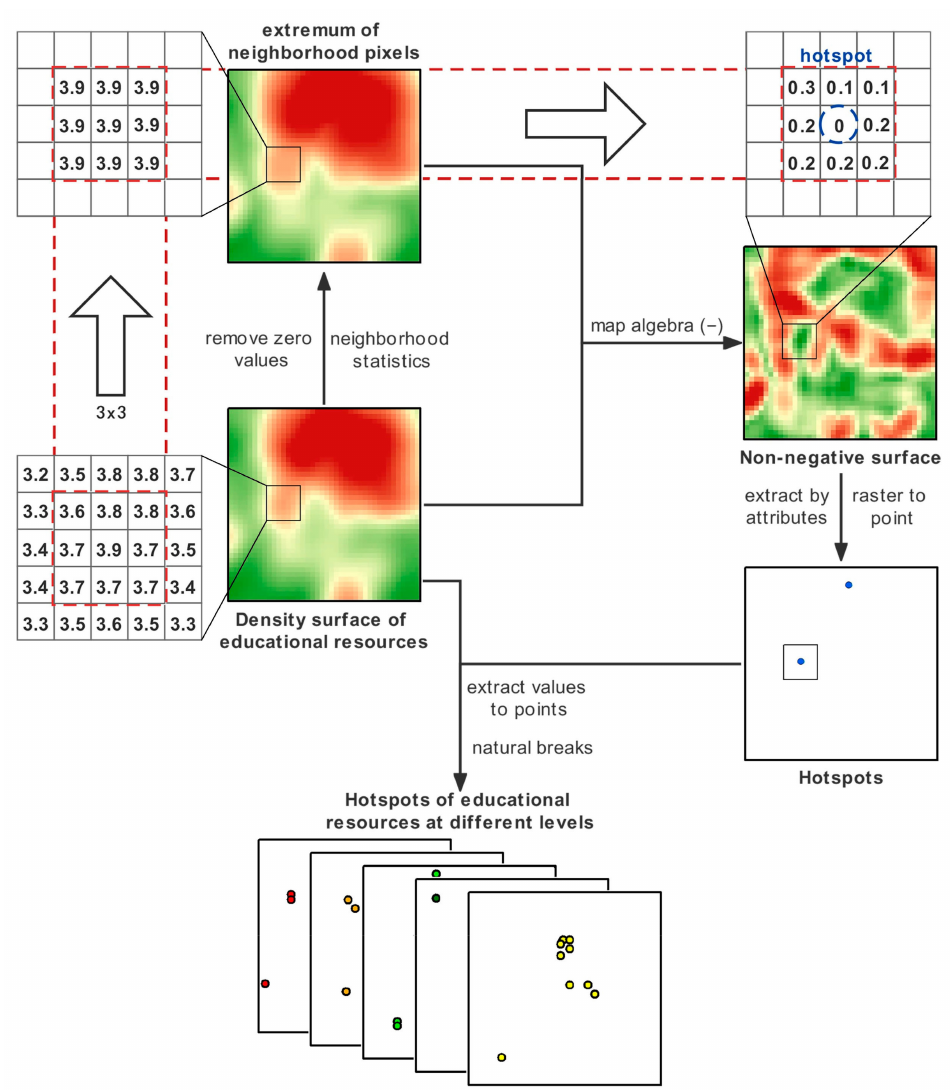
Figure 9. Process of detecting